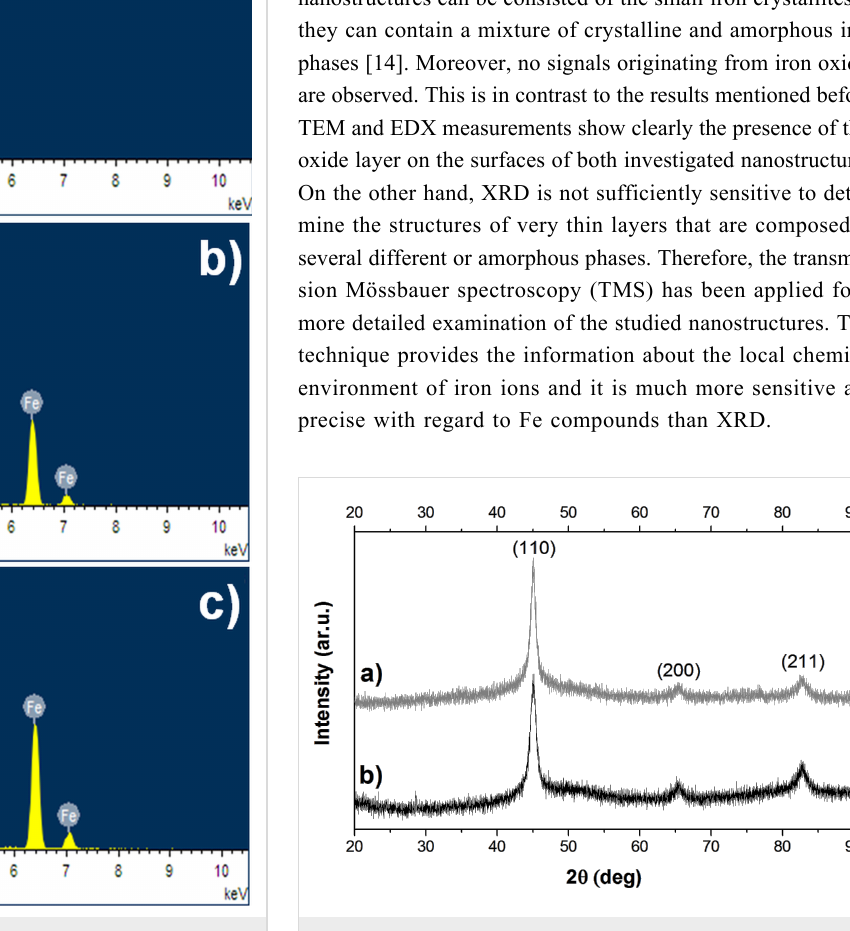
Figure 2: EDX spectra of the sample holder with: a) graphite cover; b) iron nanowires and c) iron nanoparticles.